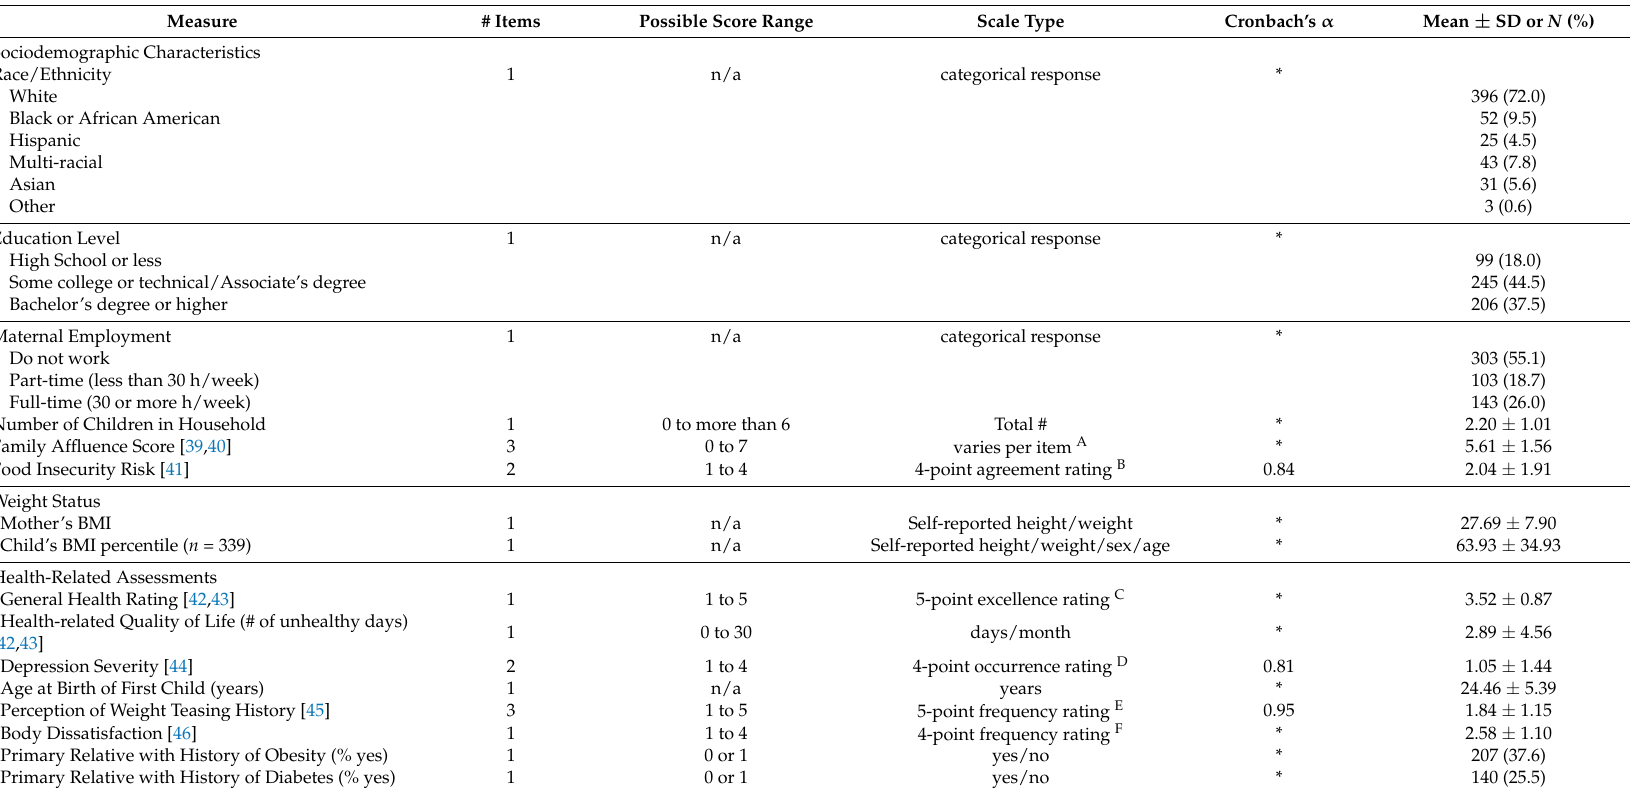
Table 1. Description of Sociodemographic, Intrapersonal, Interpersonal and Home Environment Characteristics of Participants ( N = 550). Measure # Items Possible Score Range Scale Type Cronbach’s α Mean ± SD or N